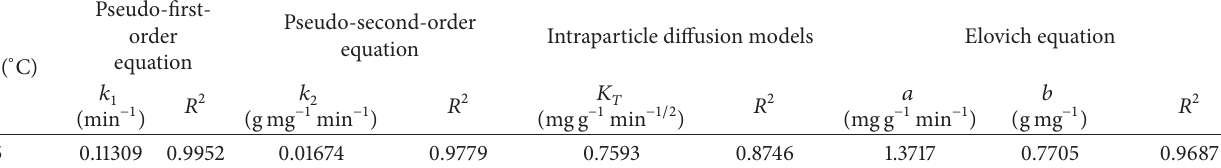
Table 2: The kinetic parameters for MB adsorption onto AC1.